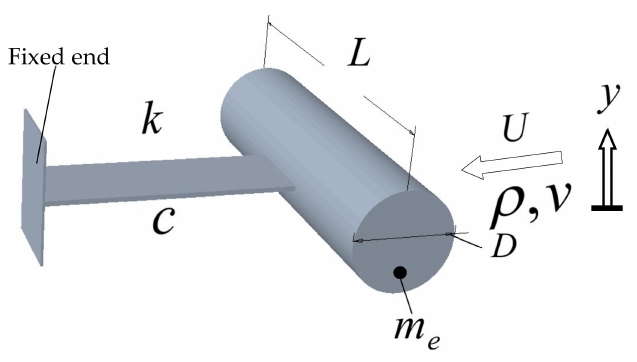
Figure 1. Overall